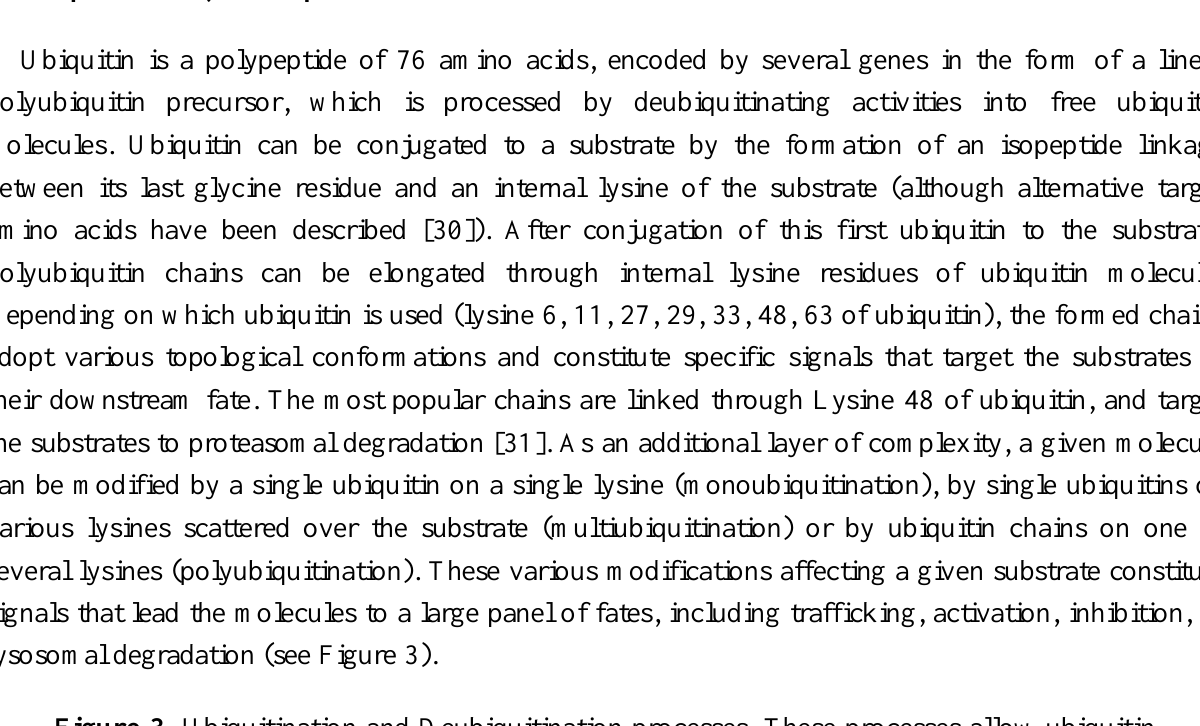
Figure 3. Ubiquitination and Deubiquitination processes. These processes allow ubiquitin to be recycled, whereas the substrates undergo various fates. Ub: Ubiquitin; E1: Ubiquitin Activating Enzyme; E2: Ubiquitin Conjugating Enzyme; E3: Ubiquitin Ligase; DUB: Deubiquitinating